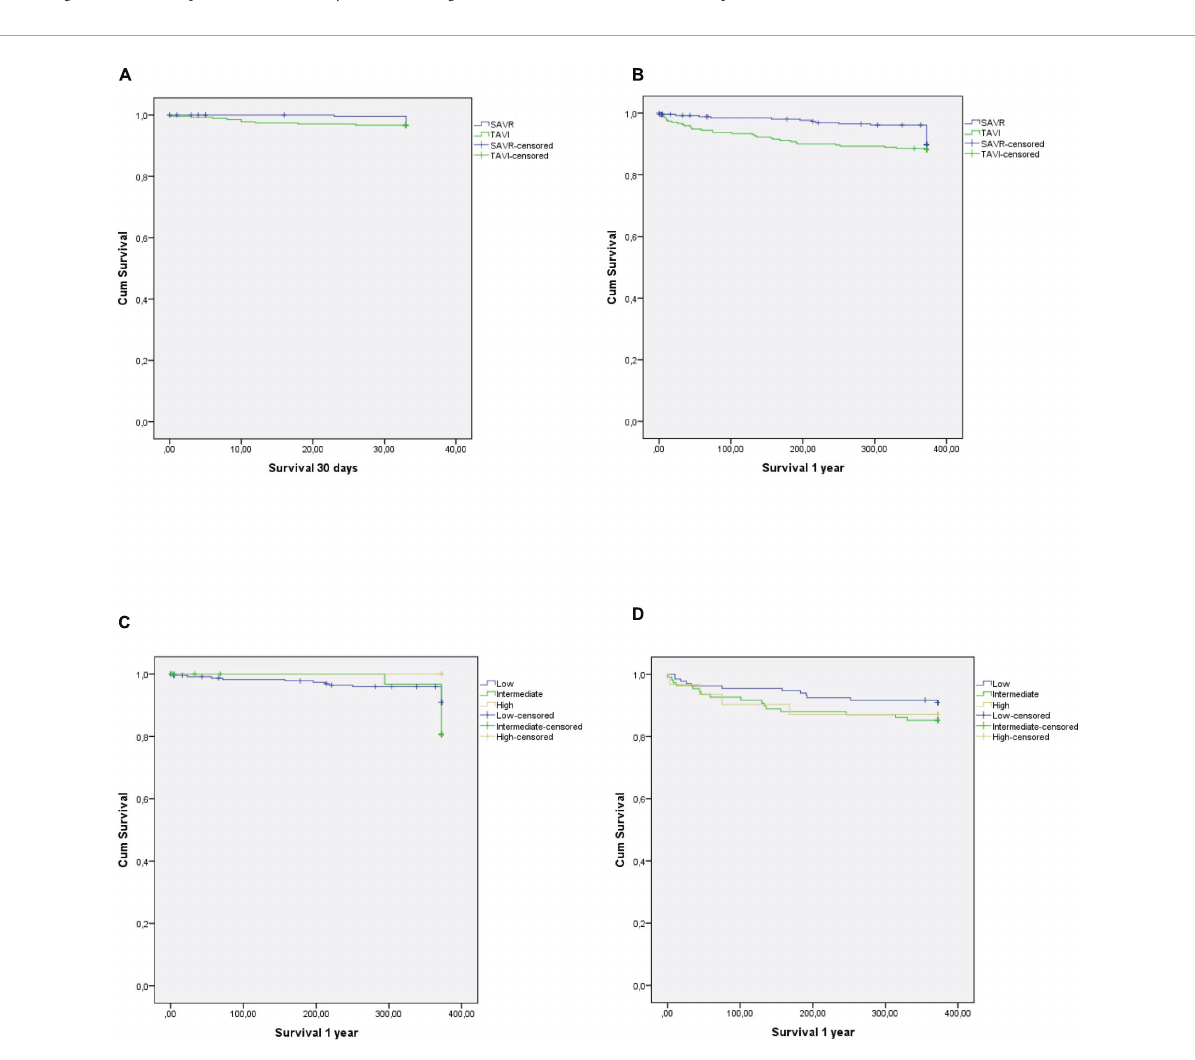
FIGURE2 Kaplan-Meier survival curves according to TAVI or SAVR: (A) SAVR vs. TAVI—30-day survival, (B) SAVR vs. TAVI—1-year survival, (C) SAVR—1-year survival stratified by STS score, (D) TAVI—1-year survival stratified by STS score; SAVR, surgical aortic valve replacement; STS, Society of Thoracic Surgeons; TAVI, transcatheter aortic valve